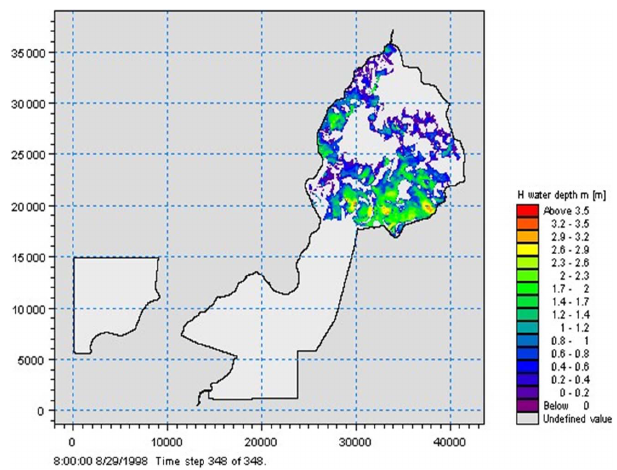
Figure 12. Submerged area in scenario